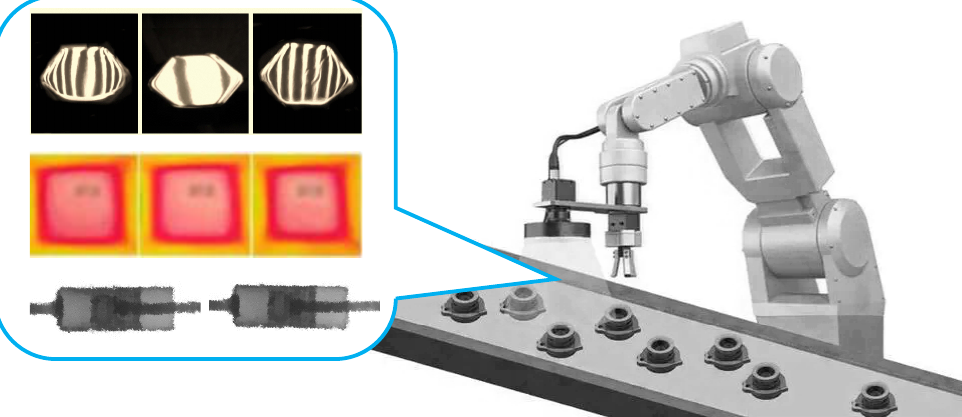
Figure 1. Example images of different modalities of visual robotic systems in automatic assembly lines. From top to bottom are visible light, infrared, and